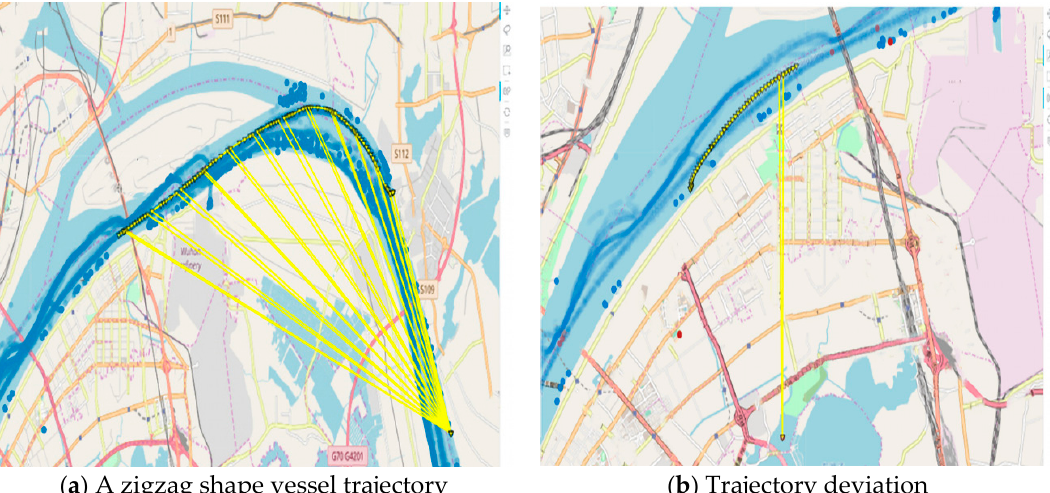
Figure 12. Abnormal AIS trajectory.